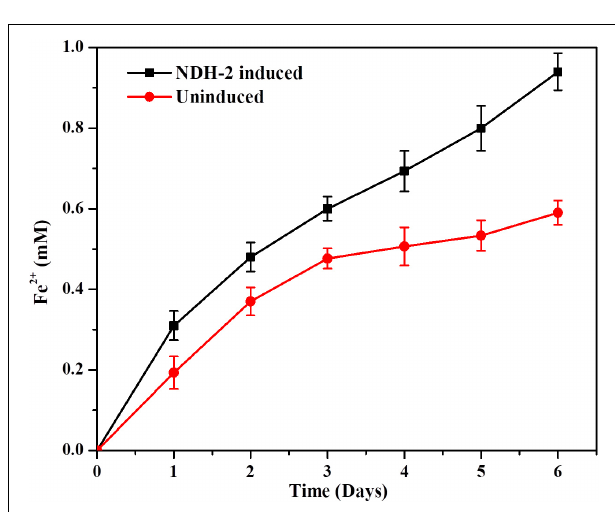
FIGURE 10 | Iron reduction by NDH-2 and wild type cells using Ferrozine assay with respect to